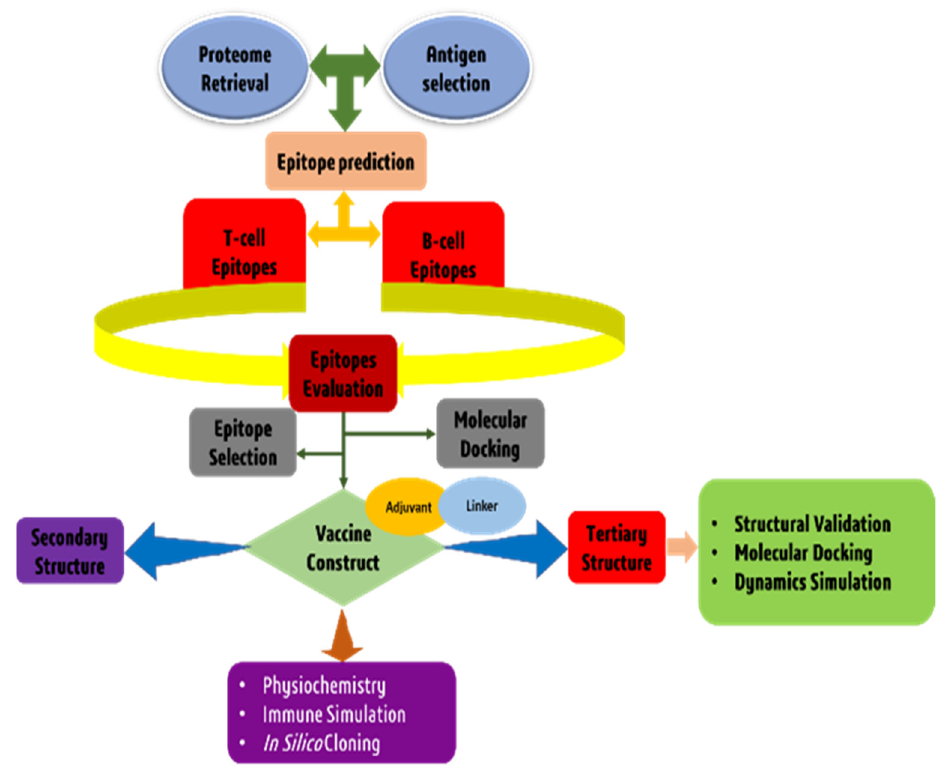
Figure 1. A diagram showing the architectural flow chart of the methodology .